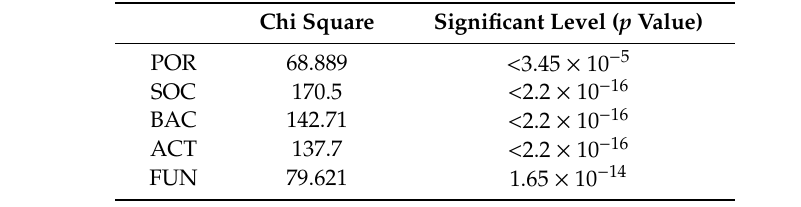
Table 1. Kruskal–Wallis H test for the variation of soil health parameters among vegetation types.